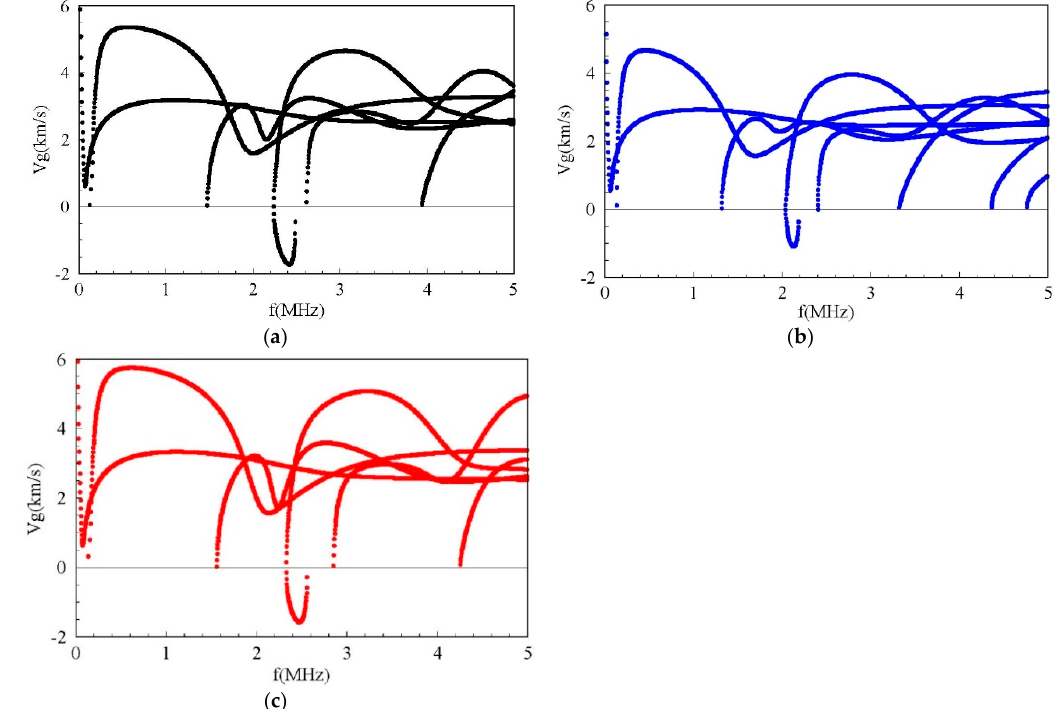
Figure 13. Group velocity dispersion curves of the Lamb-like wave for different FGMP spherical curved plates: ( a ) linear graded field, ( b ) cubic graded field, ( c ) sinusoidal graded field.